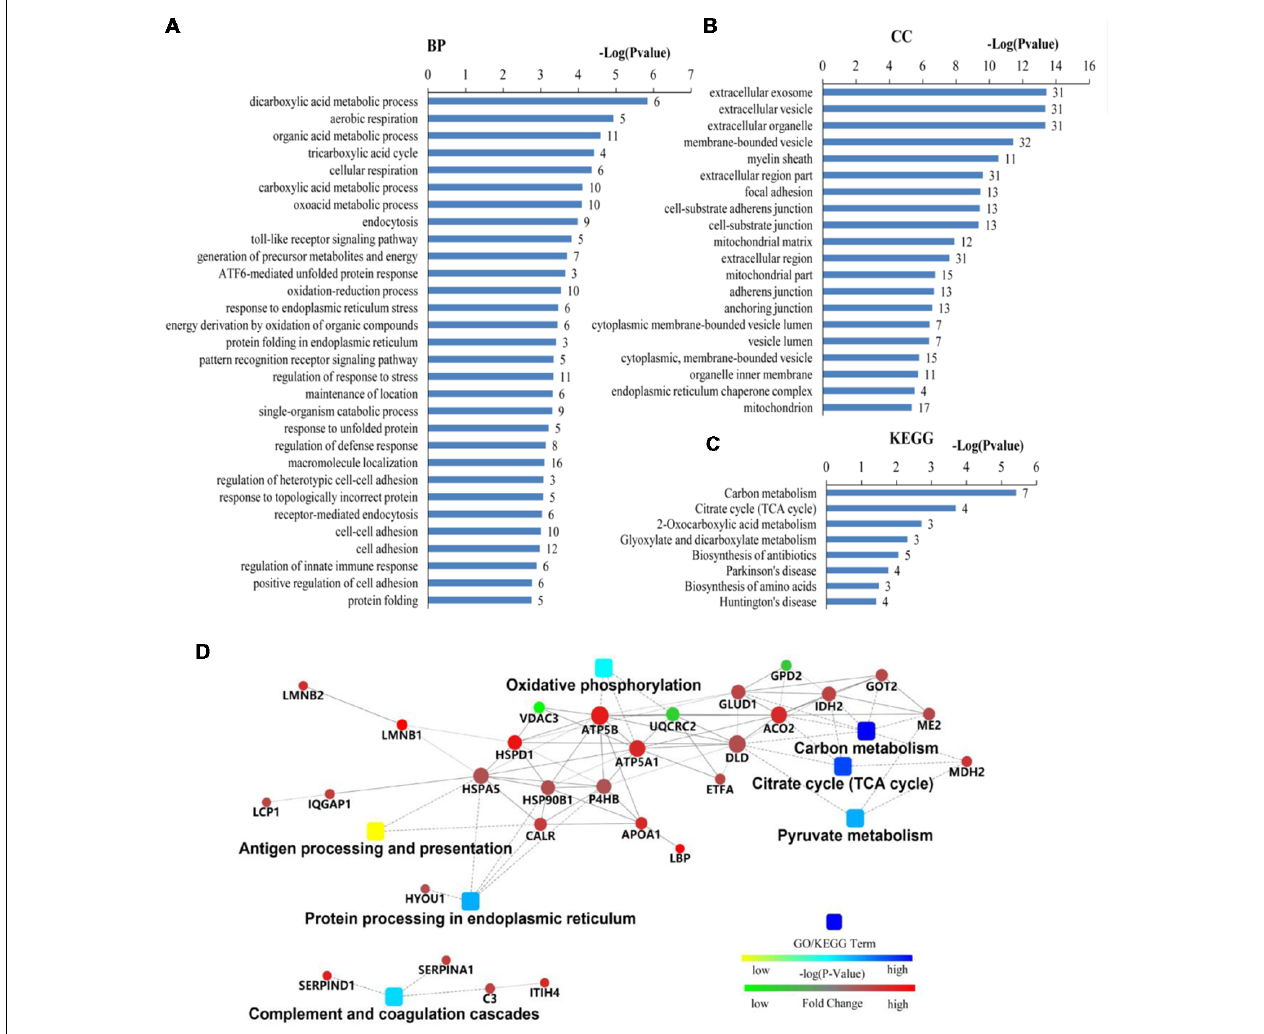
FIGURE 3 | Bioinformatics analysis of 41 differentially expressed proteins in peripheral blood mononuclear cells (PBMCs) from autistic children and healthy subjects. (A) The top 30 ranking of biological process (BP) based on gene ontology (GO). (B) The top 20 ranking of cellular components (CCs) based on GO. (C) By using DAVID analysis, the Kyoto Encyclopedia of Genes and Genomes (KEGG) signal transduction pathways are associated with these proteins. (D) Protein-protein interaction (PPI) networks of differentially expressed proteins. The networks analysis was carried out by using OMICSBEAN. (A–C) Number of proteins associated with each category and P -value for gene-enrichment analysis is shown on the right of each term